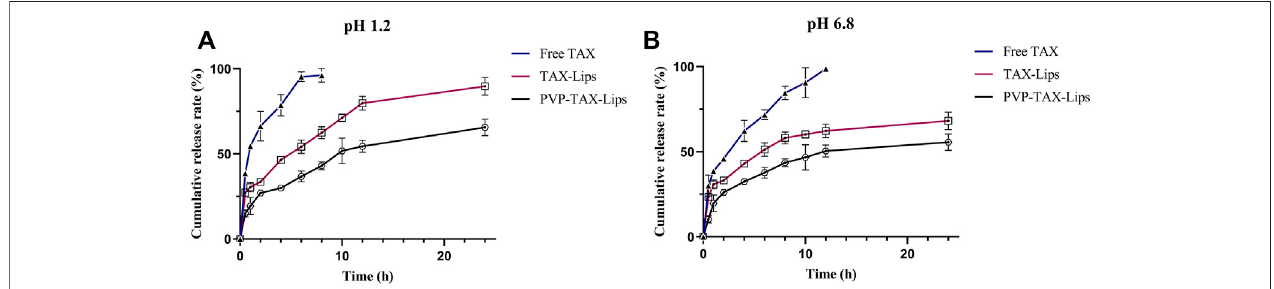
FIGURE 3 | (A) In vitro release pro fi les of free TAX, TAX-Lips, and PVP-TAX-Lips in simulated gastric juice (pH = 1.2). (B) In vitro release pro fi les of free TAX, TAX- Lips, and PVP-TAX-Lips in simulated intestinal fl uids juice (pH = 6.8) (mean ± SD, n =